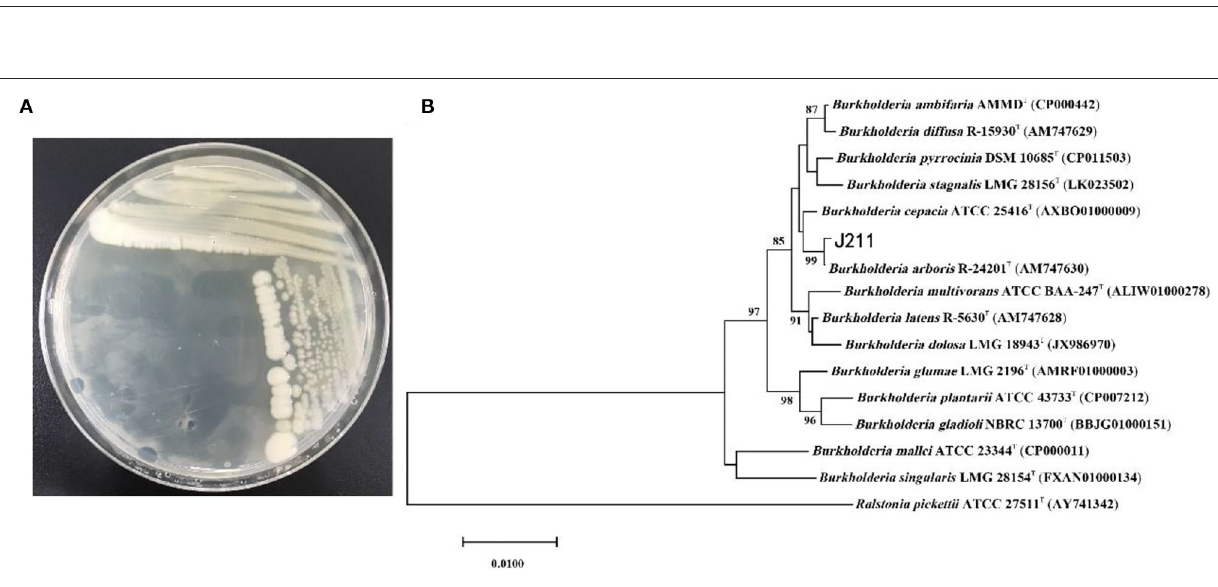
FIGURE 2 | Colony morphology and phylogenetic tree of strain J211. Colony morphology of J211 on NA medium (A) . Phylogenetic tree constructed with J211 and other type strains of related species in Burkholderia based on16s rRNA gene sequences (B) . The bootstrap consensus tree, inferred from 1,000 replicates, was reconstructed using the neighbor-joining (NJ) method based on the general time-reversible model.